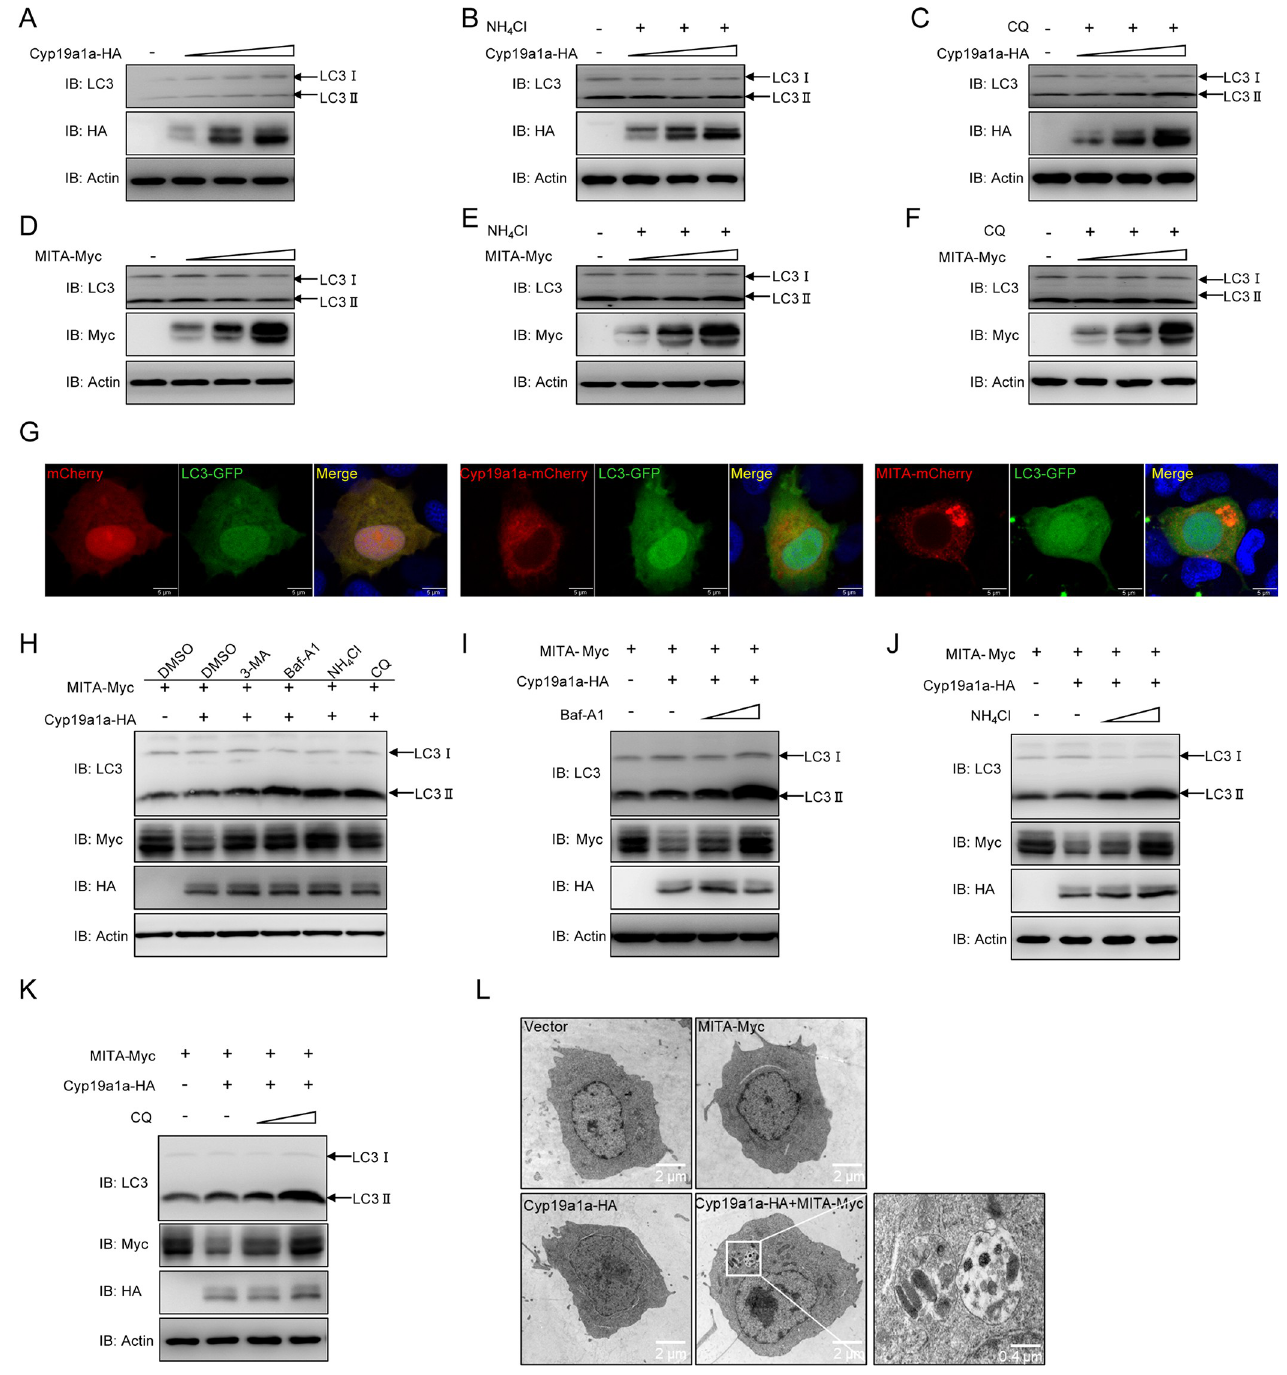
Fig 6. Co-transfection of Cyp19a1a and MITA triggers autophagy. (A-F) EPC cells were transfected with Cyp19a1a-HA (0.5, 1, or 2 μ g) (A-C) or MITA-Myc (0.5, 1, or 2 μ g) (D-F). At 18 h post-transfection, the cells were treated with DMSO, NH 4 Cl (20 mM), or CQ (100 μ M) for 6 h. Then, the cells were harvested for IB with the indicated Abs. (G) EPC cells were co-transfected with 1 μ g pCS2-mCherry, Cyp19a1a-mCherry, or MITA-mCherry plus 1 μ g LC3-GFP. After 24 h, the cells were fixed and observed by confocal microscopy. Red signals represent overexpressed Cyp19a1a or MITA, green signals represent overexpressed LC3 (original magnification 63 × ; oil immersion objective). Scale bar, 10 μ m. (H) EPC cells were co-transfected the indicated plasmids. At 18 h post-transfection, the cells were treated with DMSO, 3-MA (2 mM), Baf-A1 (100 nM), NH 4 Cl (20 mM), or CQ (100 μ M) for 6 h. The cell lysates were subjected to IB with the anti- LC3, anti-Myc, anti-HA, and anti- β -actin Abs, respectively. (I-K) EPC cells were co-transfected the indicated plasmids. At 18 h post-transfection, the cells were treated with DMSO, Baf-A1 (50 or 100 nM), NH 4 Cl (10 or 20 mM), or CQ (50 or 100 μ M) for 6 h. The cell lysates were subjected to IB with the indicated Abs. (L) EPC cells were transfected with indicated plasmids for 24 h. Then the cells were analyzed for autophagosome formation using a transmission electron microscope. Images on the right correspond to the squared zoomed images in each panel. Scale bar, 2 μ m.